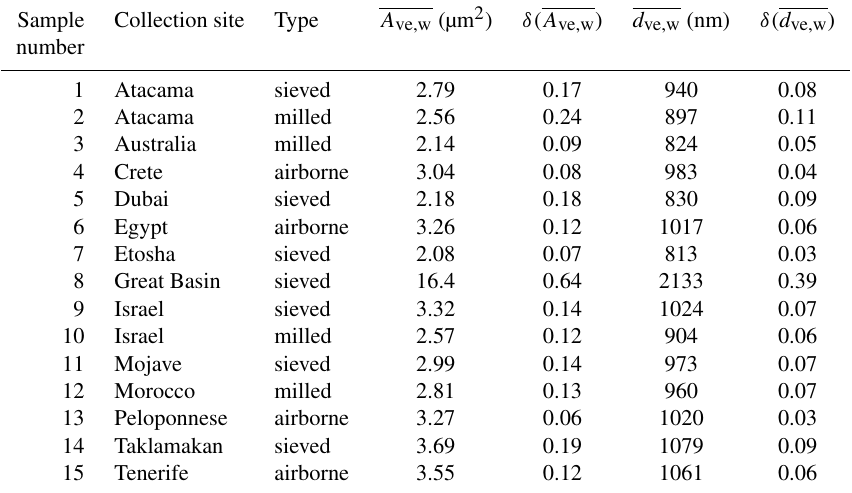
Table 1. Overview of the dust size distribution parameters: the mean particle surface area per particle A ve,w with relative error δ(A ve,w ) and the corresponding diameter of a particle with this surface area ( d ve,w ) with the relative error δ(d ve,w